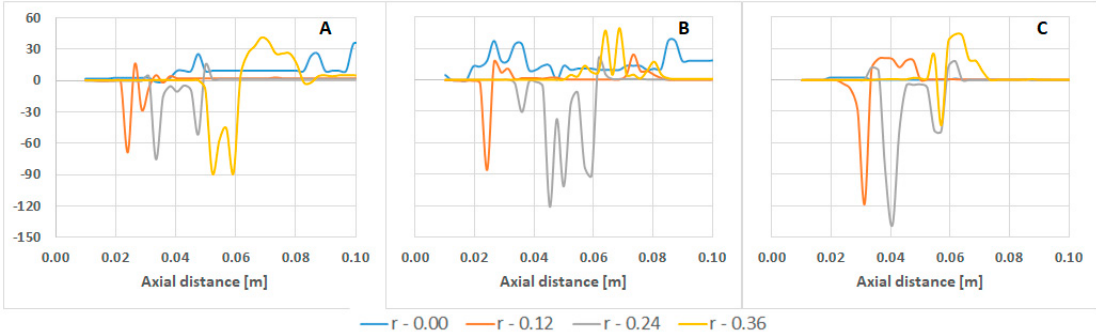
Figure 12. H 2 production at di ff erent radius (0.00, 0.12, 0.24, 0.36) (r) along the axis, ( A ) 1450 K; ( B ) Figure 12. H 2 production at different radius (0.00, 0.12, 0.24, 0.36) (r) along the axis, ( A ) 1450 K; ( B ) Figure 12. H 2 production at different radius (0.00, 0.12, 0.24, 0.36) (r) along the axis, ( A ) 1450 K; ( B ) Figure 12. H 2 production at different radius (0.00, 0.12, 0.24, 0.36) (r) along the axis, ( A ) 1450 K; ( B ) 1800 K; ( C ) 1800 K; ( C ) adiabatic. 1800 K; ( C ) adiabatic. 1800 K; ( C ) adiabatic.